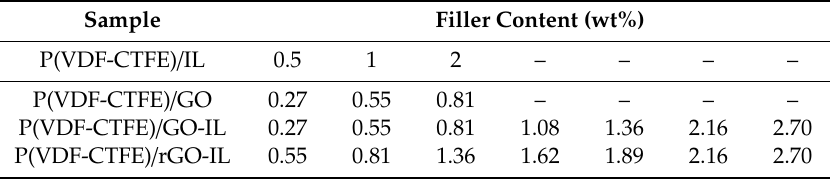
Table 1. Di ff erent compositions of P(VDF-CTFE) composites processed in this work.